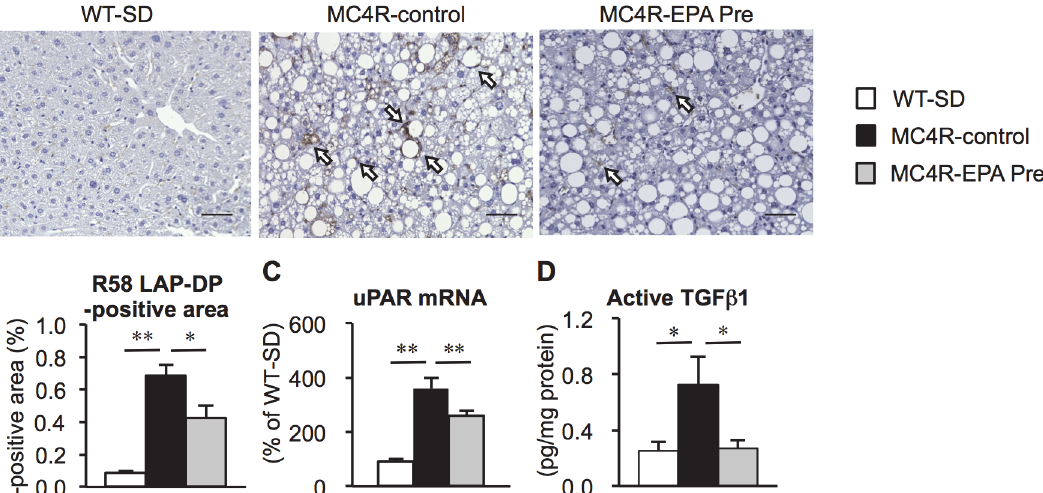
Fig 5. Effect of EPA on hepatic TGF β activation in MC4R-KO mice. (A) Immmunostaining with anti-R58 LAP-DP antibody to determine TGF β activation in the liver after 24 weeks of EPA treatment. (B) Quantification of the R58 LAP-DP-positive area. (C) Hepatic mRNA expression of urokinase-type plasminogen activator receptor (uPAR). (D) Active TGF β protein levels in the liver. Scale bars, 50 μ m. * P < 0.05; ** P < 0.01. WT-SD, n = 8; MC4R-control, n = 7; MC4R-EPA Pre, n = 10.